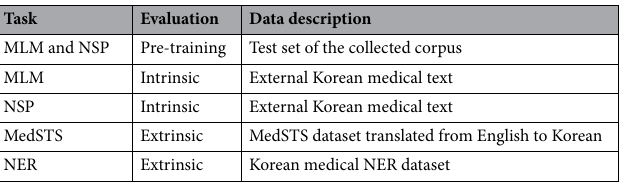
Table 1. Description for datasets used in